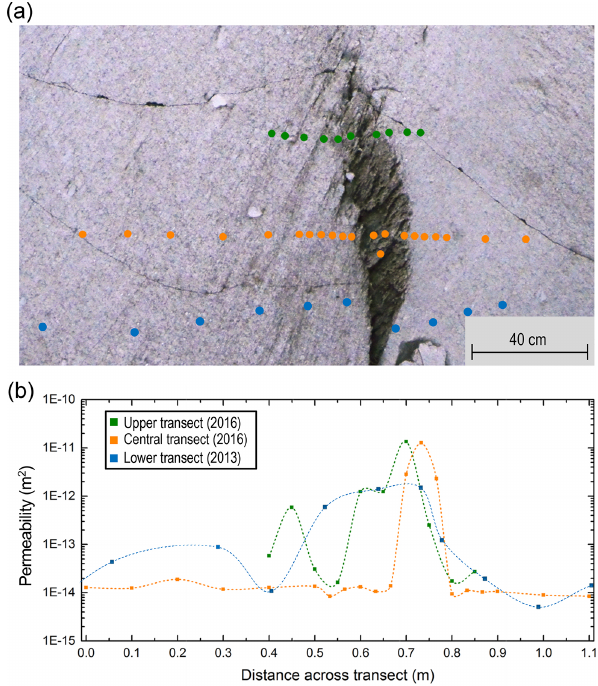
Figure 7. (a) Photograph showing measurement locations of the field-based permeability measurements for the upper (green), cen- tral (orange), and lower (blue) transects. (b) Permeability data for the upper (green), central (orange), and lower (blue) transects tran- sects plotted against distance. The data show a drastic increase in permeability of ∼ 3 orders of